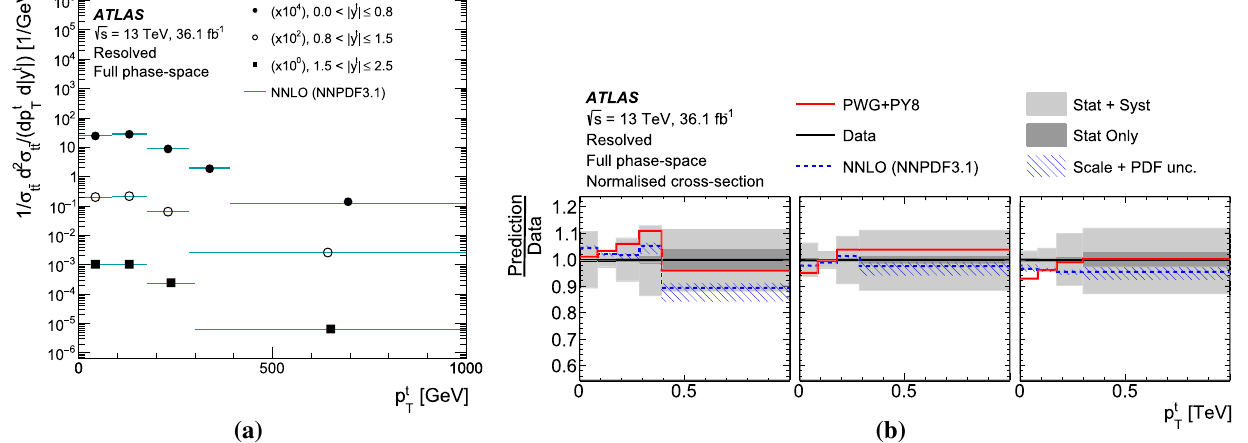
Fig. 58 a Parton-level normalised differential cross-section as a func- (cid:7) (cid:7) (cid:7) in the resolved topology compared with the (cid:7) y t tion of p t in bins of T NNLO prediction obtained using the NNPDF3.1 NNLO PDF set. Data points are placed at the centre of each bin. b The ratio of the measured